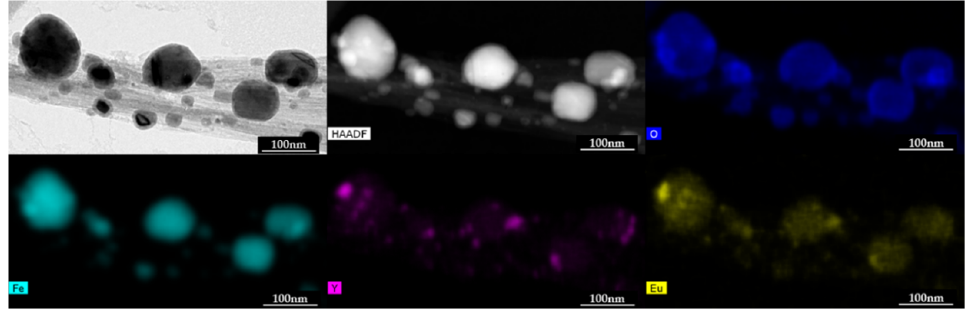
Figure 4. HRTEM, HAADF, imaging and EDX mapping of CNT bundles showing elemental distribution.